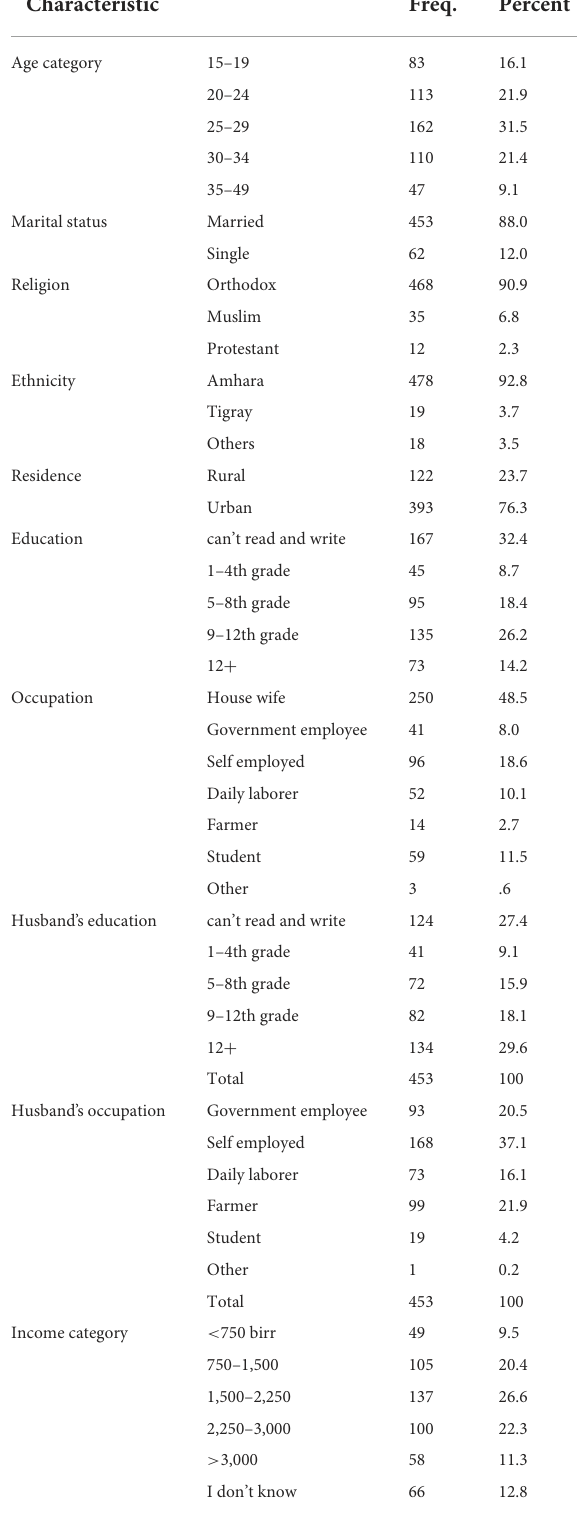
Ethiopia, April 2017. Characteristic